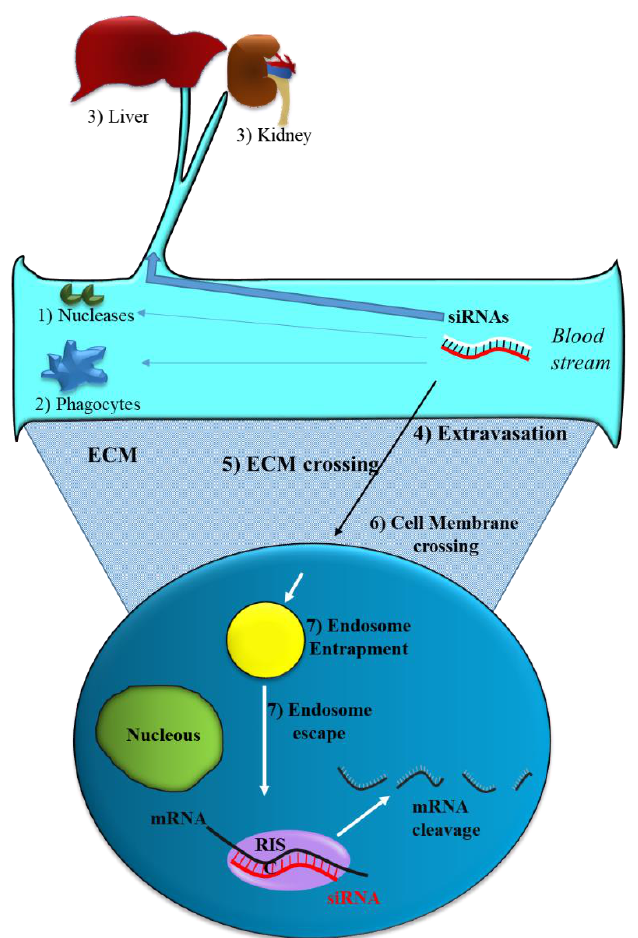
Figure 2. Obstacles to siRNA delivery. Systemically released siRNAs encounter blood nucleases (1), which can induce their rapid degradation together with the clearance by phagocytes (2) and by the liver–kidney sequestration/filtration (3). Extravasation (4), extra cellular matrix (ECM) crossing (5), cell membrane crossing (6) and endosomal escape (7) are the other barriers to be overcome by siRNAs.